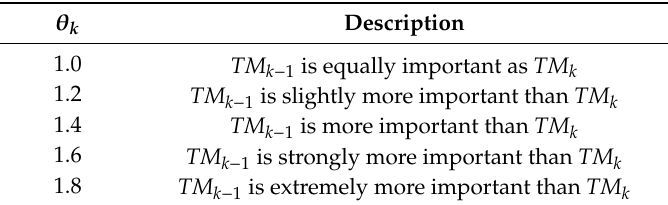
Table 1. The description of the relative importance